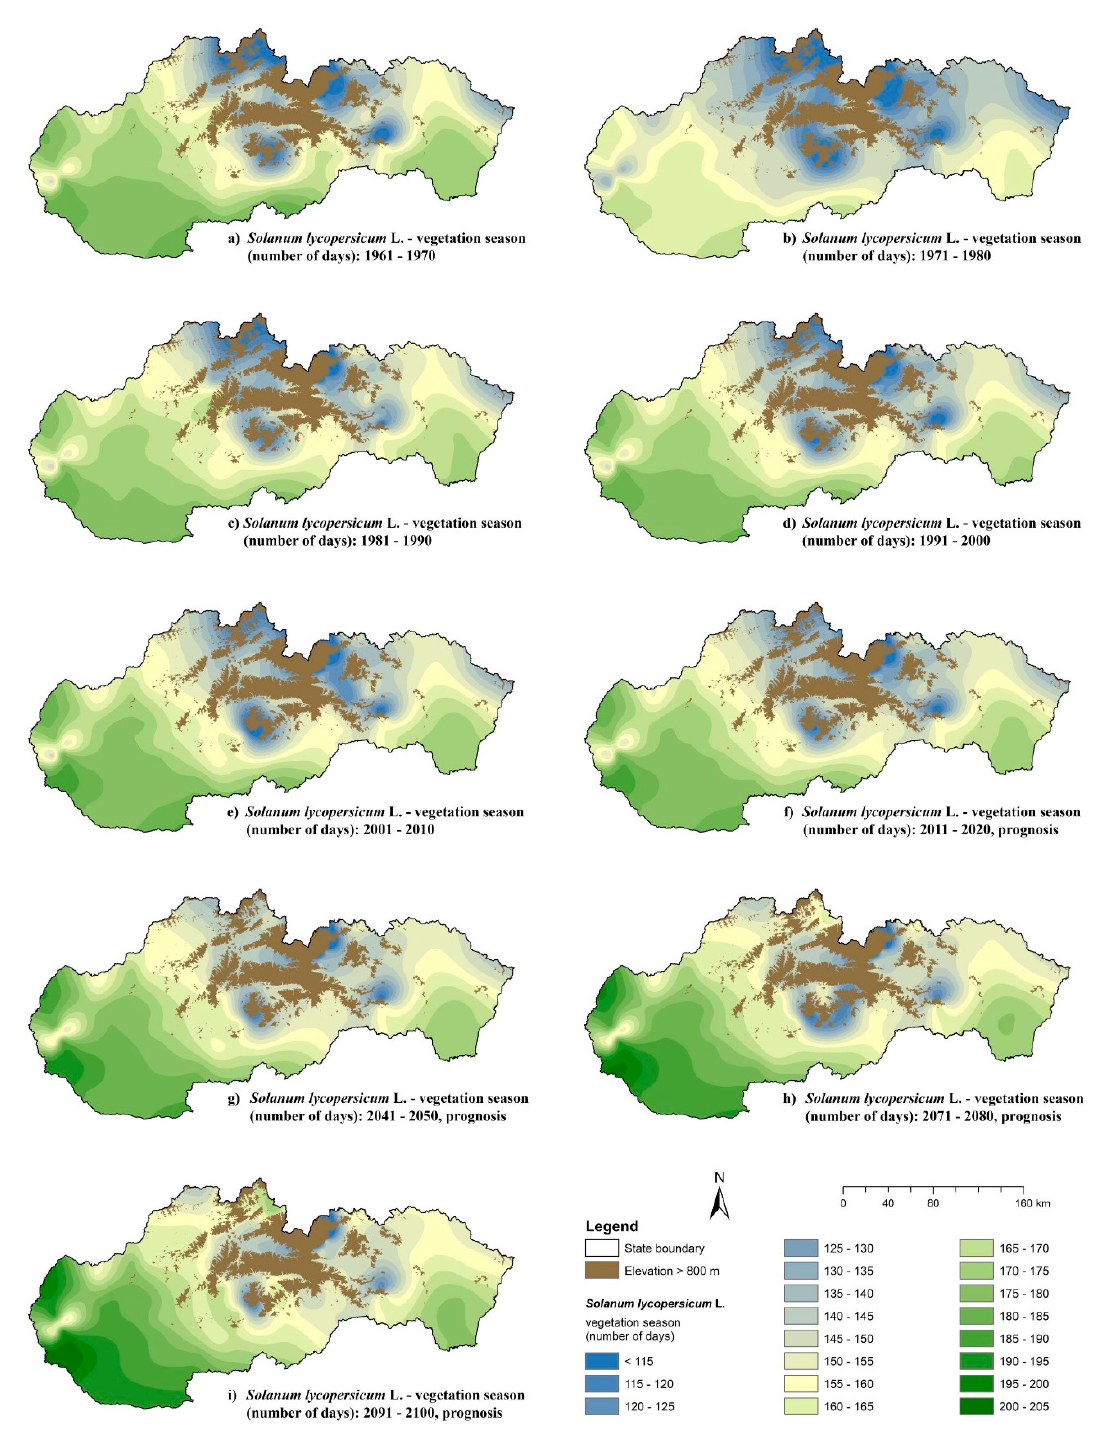
Figure 2. Vegetation period of Solanum lycopersicum L. in the decades from 1961–2100: ( a ) 1961–1970, ( b ) 1971–1980, ( c ) 1981–1990, ( d ) 1991–2000, ( e ) 2001–2010, ( f ) 2011–2020, ( g ) 2041–2050, ( h ) 2071–2080,